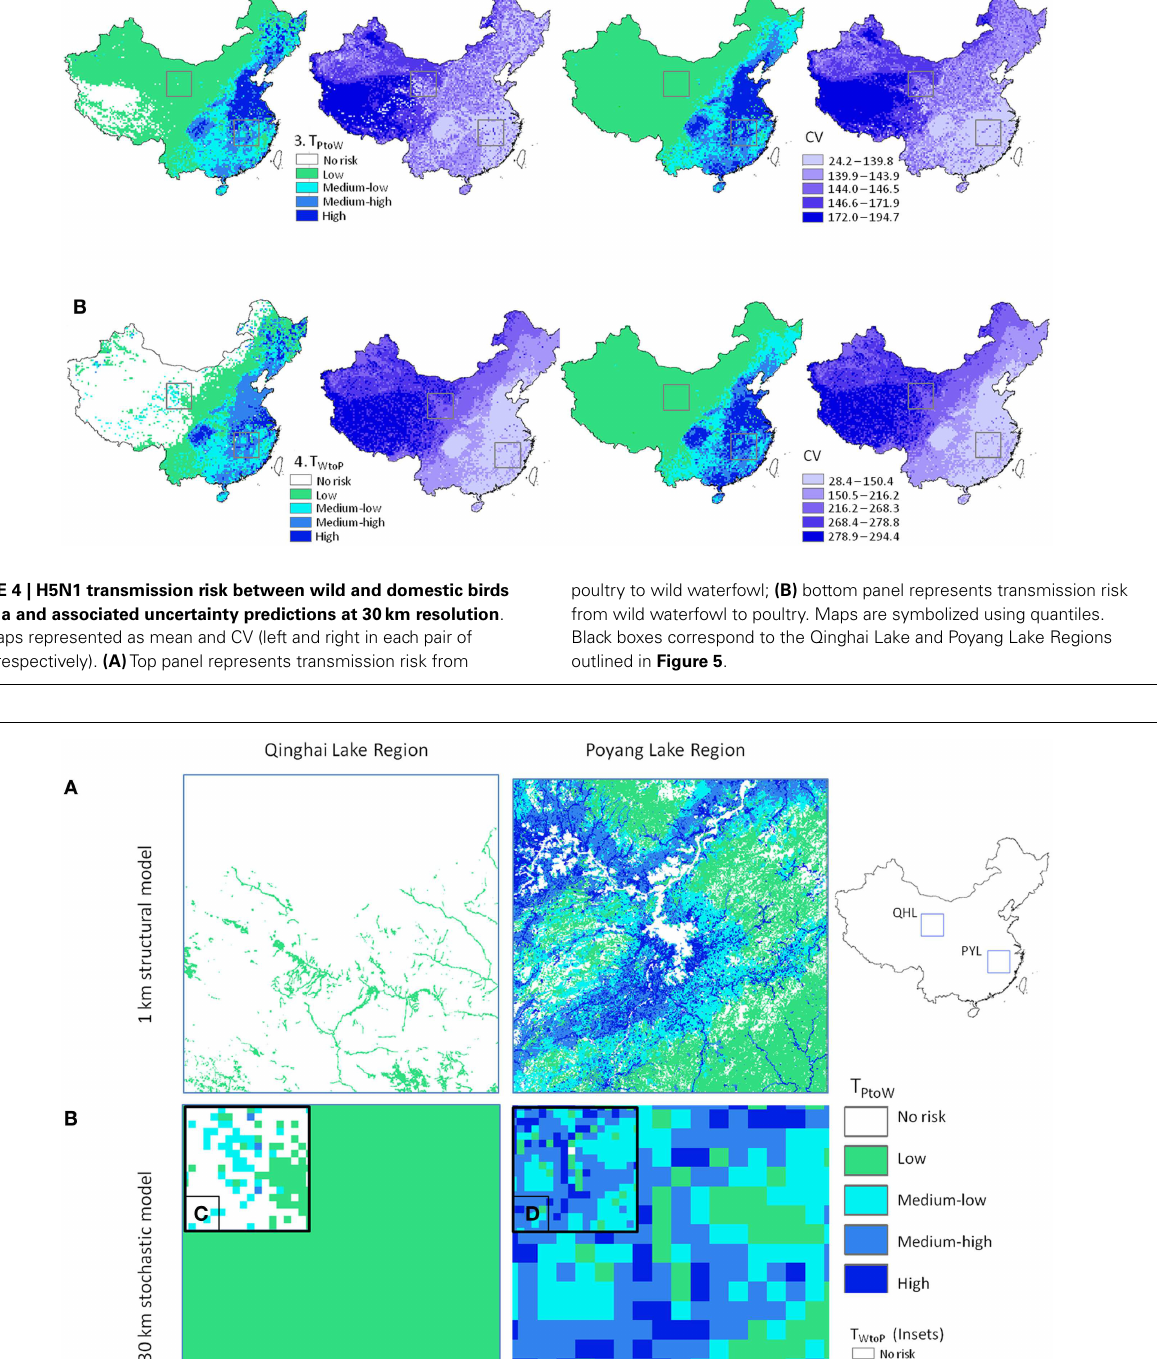
FIGURE 5 | Comparison of model outputs for Qinghai Lake (QHL) and Poyang Lake (PYL) sub-regions for (A) 1km deterministic and (B) 30km Monte-Carlo model outputs using Eq. 3 (poultry to wild transmission risk) for the winter season . Insets (C,D) show comparisons for the breeding season Eq. 4 (wild to poultry